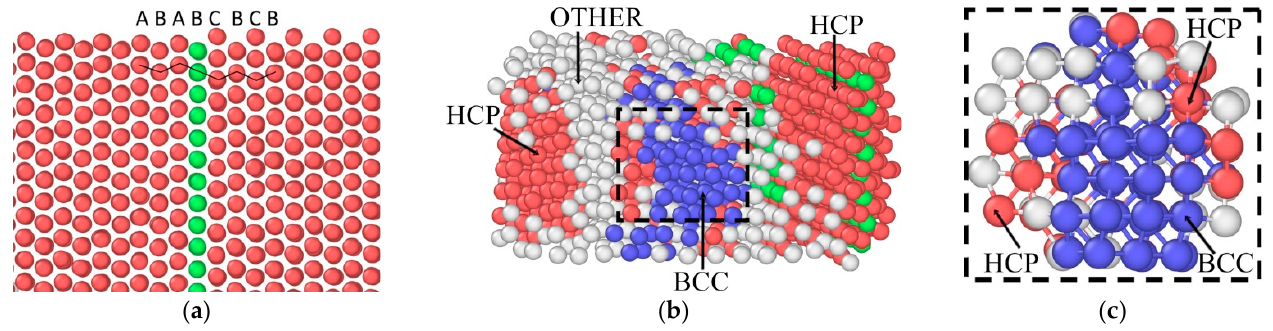
Figure 7. The microstructure of a layer of the titanium crystallite in the YZ plane 2 nm thick with X coordinates of 31 ( a ), 47 ( b ), and 63 nm ( c ) after the first ( a ), second ( b ) and third ( c ) penetrations of the indenter. Atoms that had formed the crystal lattice, in which some of them were displaced from their sites, are marked in light gray.